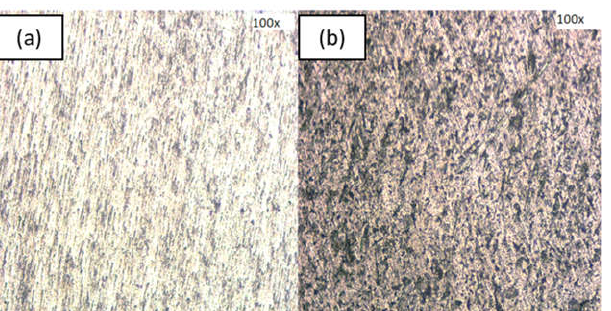
Figure 6. Optical photomicrograph of Al359/Si3N4/Eggshell surface composites. ( a ) stir zone (SZ) ( b ) thermomechanical affected zone (TMAZ).